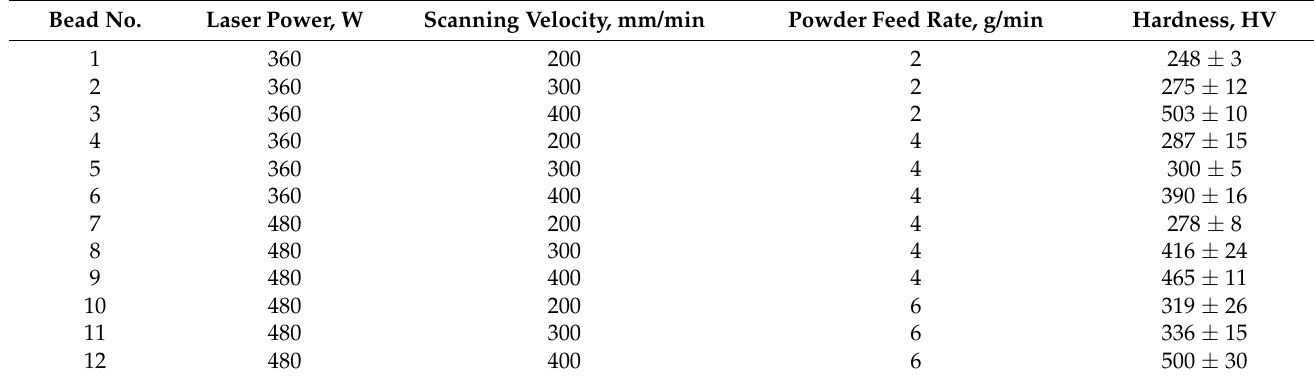
Table 5. Hardness of the Mo coatings depending on the LDED working parameters. Bead No.